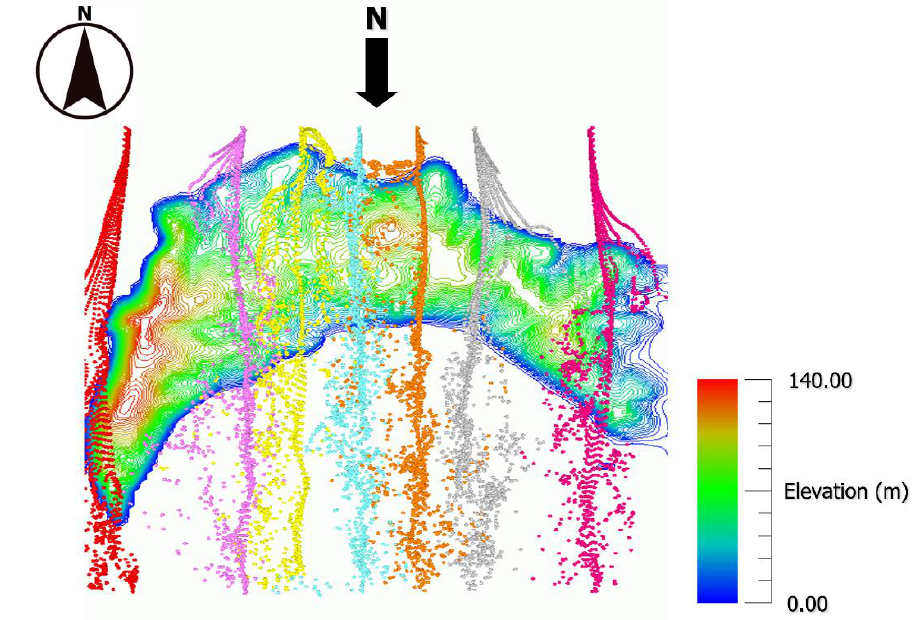
Figure 15. Numerical flow visualization over Noma Wind Park by using the passive particle tracking method. Table 3. Characteristics of the wind at Noma Wind Park for the year from April 2004 to March 2005. Hub Height Elevation of the WT Site (m)